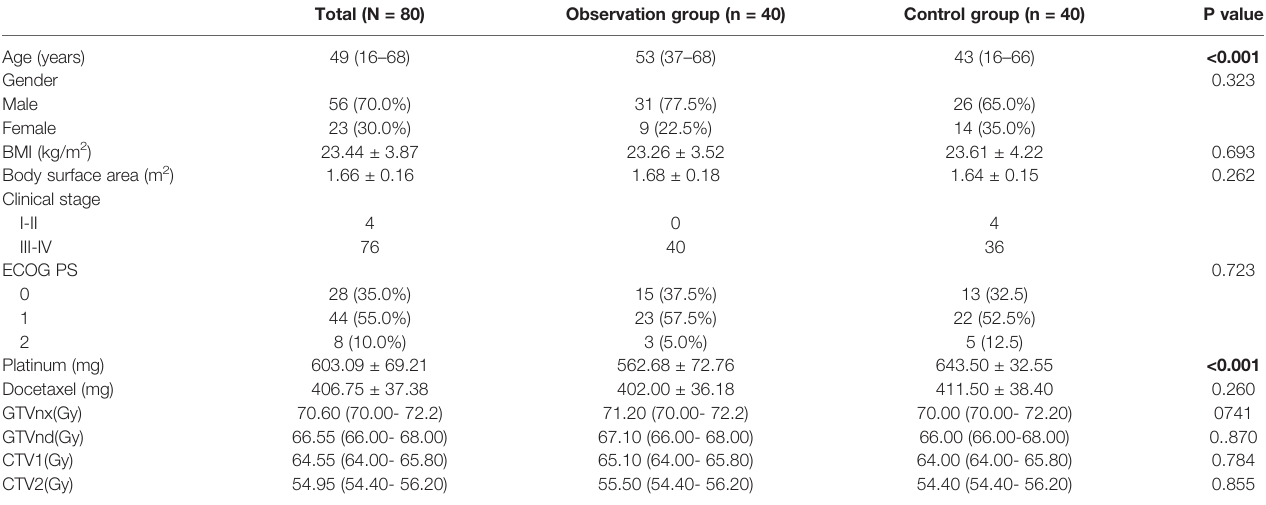
Bold values show the signi fi cant differences between two